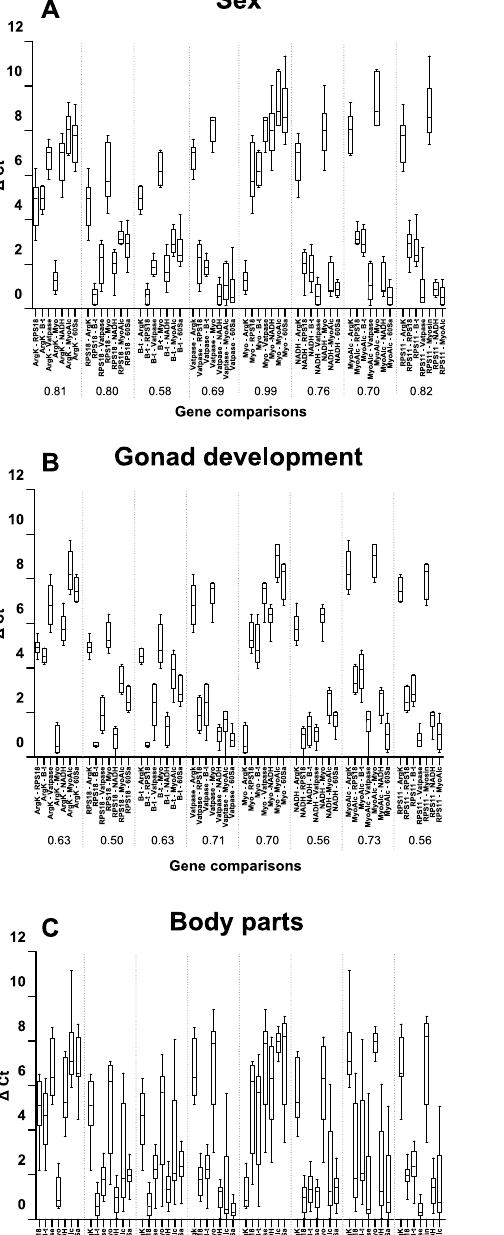
development comparison in C . campestris as both RPS18 and RPS11 were top-ranked by all four algorithms. RPS11 was ranked among the most stables genes for the body parts comparison in C . campestris , contrary to RPS18 which was not placed among the top-ranked genes in either both species. Previous studies in insects showed good stabilities of ribosomal proteins in developmental and tissue comparisons 23,28,46–48 . Nevertheless, RPS18 , which was the most constant gene after bacterial infection in Apis mellifera 44 , showed the least stable val- ues in C . littoralis after the treatment. This highlights the necessity of a proper validation to find the optimal refer- ence gene for each species and specific condition. Additionally, several ribosomal proteins were also validated in T . castaneum after a fungal challenge 22 , RPS9 was proved to be suitable for RNAi experiments 27 , and RPS18 and